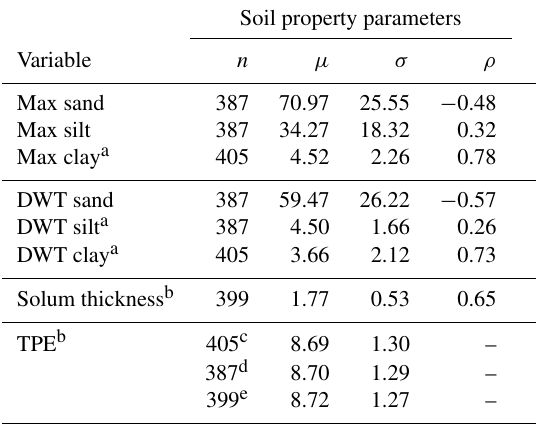
Table 2. Parameters for the bivariate normal probability distribu- tions for the soil physical properties and TPE; n is number of pro- files; µ is mean; σ is standard deviation; and ρ is Pearson’s corre- lation between soil variables and total pedogenic energy. Soil property parameters